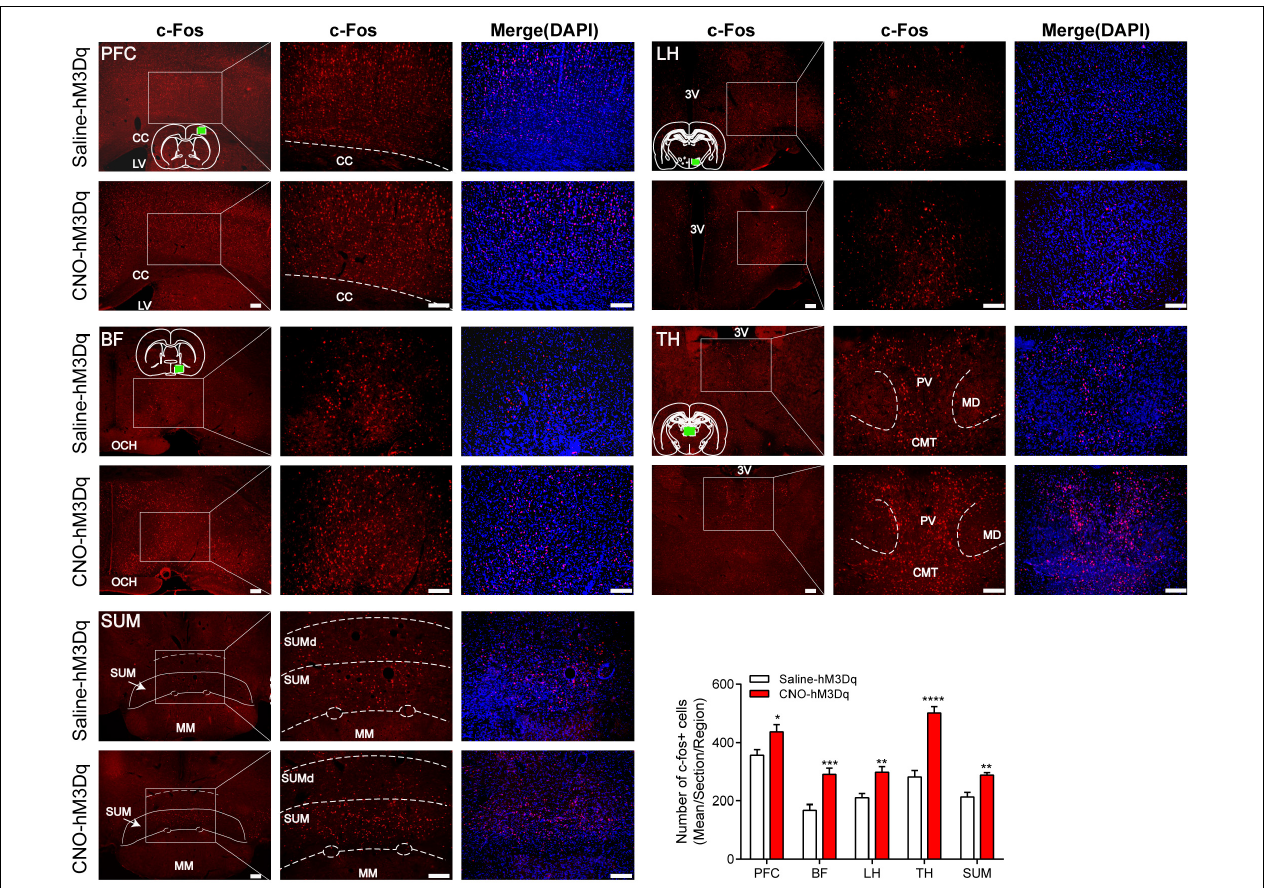
FIGURE 6 | c-Fos expression in prefrontal cortex (PFC), basal forebrain (BF), lateral hypothalamus (LH), thalamus (TH), and supramammillary nucleus (SUM) 2 h after hM3Dq rats received CNO or saline. Green box in the standard rat brain map indicates the part where we counted. The PBN activation group shows an increase in c-Fos expression compared to the PBN non-activation group in these five areas. Data are expressed as mean ± SEM. Unpaired Student’s t -tests are used for comparisons. ∗ p < 0.05, ∗∗ p < 0.01, ∗∗∗ p < 0.001 and ∗∗∗∗ p < 0.0001. Bar = 100 µ m. LV, lateral ventricles. 3V, the third ventricle. OCH, optic chiasm. PV, paraventricular thalamic nucleus; MD, mediodorsal thalamic nucleus; CMT, central medial thalamic nucleus; SUM, supramammillary nucleus; SUMd, supramammillary decussation; MM, mamillary